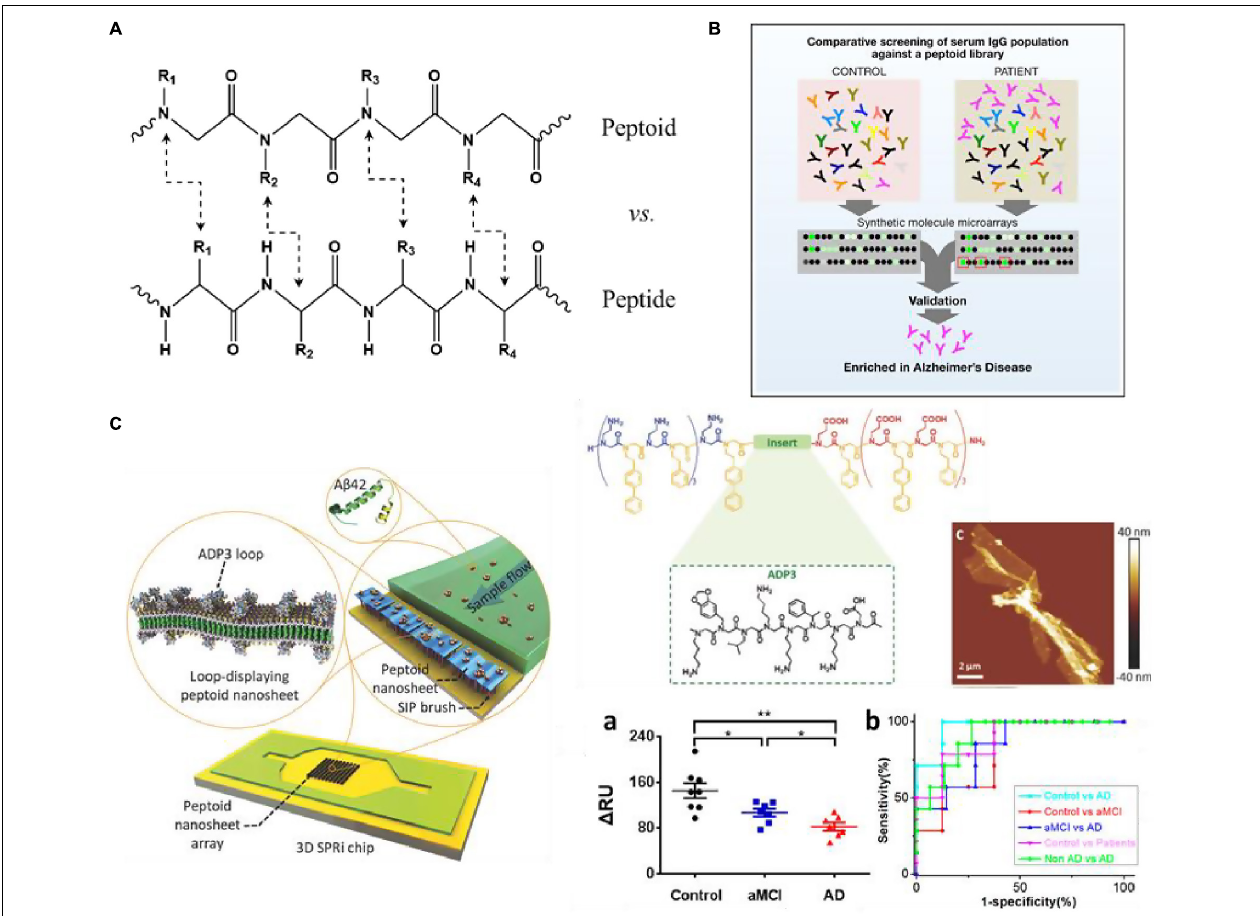
FIGURE 5 | (A) Chemical structure comparison of peptide and peptoid; (B) schematic overview of the process employed to screen peptoids that bind to antibodies present at higher levels in AD patients (Reddy et al., 2011); (C) structure of ADP3 microarray on 3D SPRi chip to develop a rapid, label-free sensor (Zhu et al., 2017; Gao et al., 2020). Reproduced with permission. Significance comparisons between groups were calculated by one-tailed unpaired t -test with Welch’s correction. * P < 0.05, ** P <